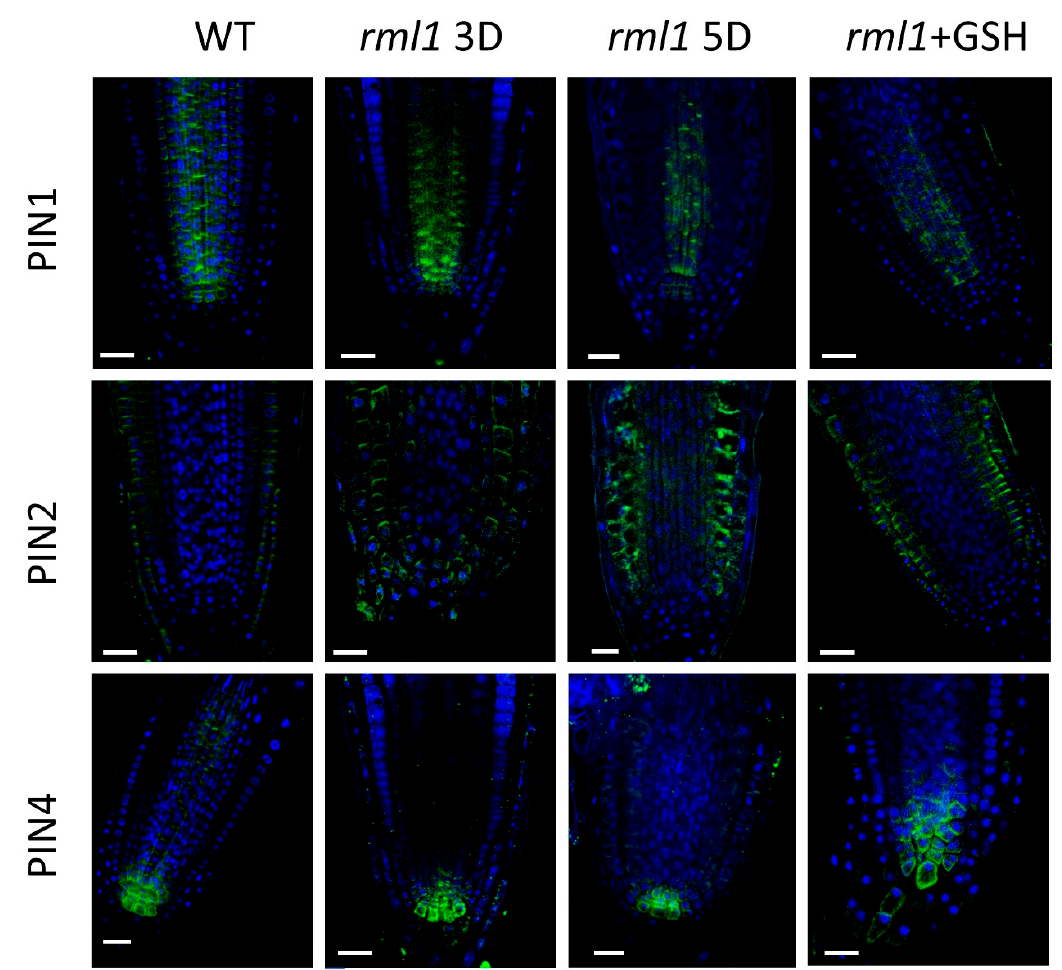
Figure 7. GSH level altered the PIN signal localization in the RAM. PIN1, PIN2, and PIN4 localization in rml1 mutant at 3 and 5 days after germination and rml1 mutants treated with 0.5 mM GSH. Scale bar − 20 µm.